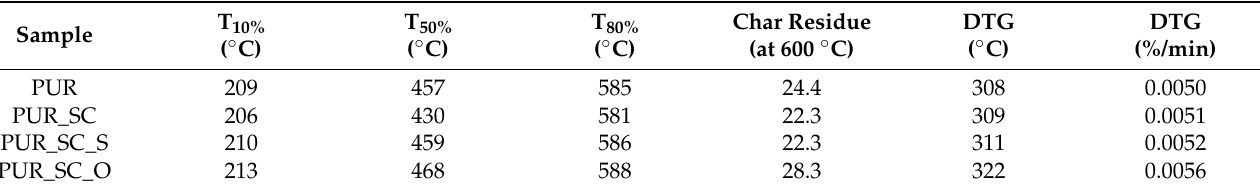
Table 4. The results of TGA and DTGA analysis.